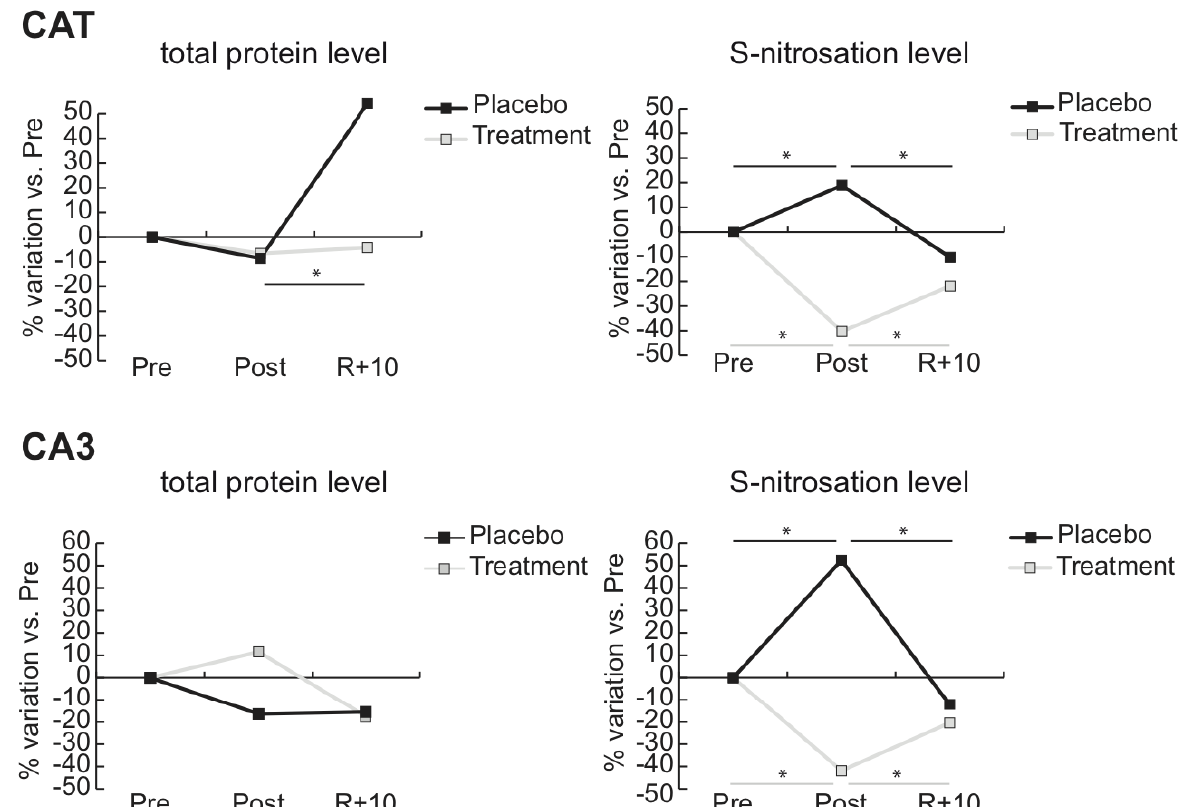
Figure 4. Total abundance and S -nitrosated protein level of catalase (CAT) and carbonic anhydrase 3 (CA3). Line charts illustrating protein abundance and S -nitrosation level variations (%) of cytosolic proteins catalase (CAT) and carbonic anhydrase 3 (CA3) in post-bedrest (Post) and recovery (R + 10) compared to pre-bedrest (Pre) condition in untreated controls (Placebo, black lines) or in subjects under antioxidant treatment (Treatment, gray lines) (* = significant difference, ANOVA and Tukey, n = 5, p -value ≤ 0.05).